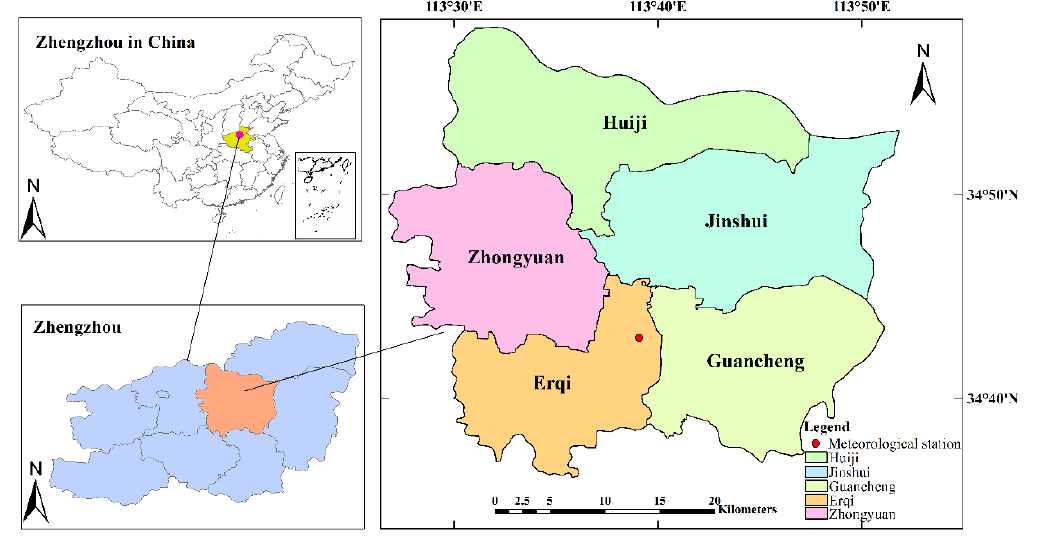
Figure 1. Map of the study area showing five municipal zones and meteorological station.